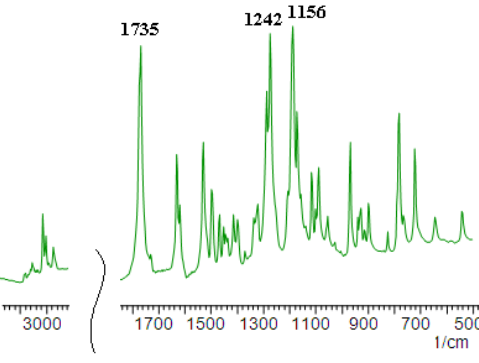
Figure 1. IR spectrum of butyl phenoxyethyl adipate. Table 2. The results of determining the critical temperature of dissolution of PVC resin in the plasticizer.